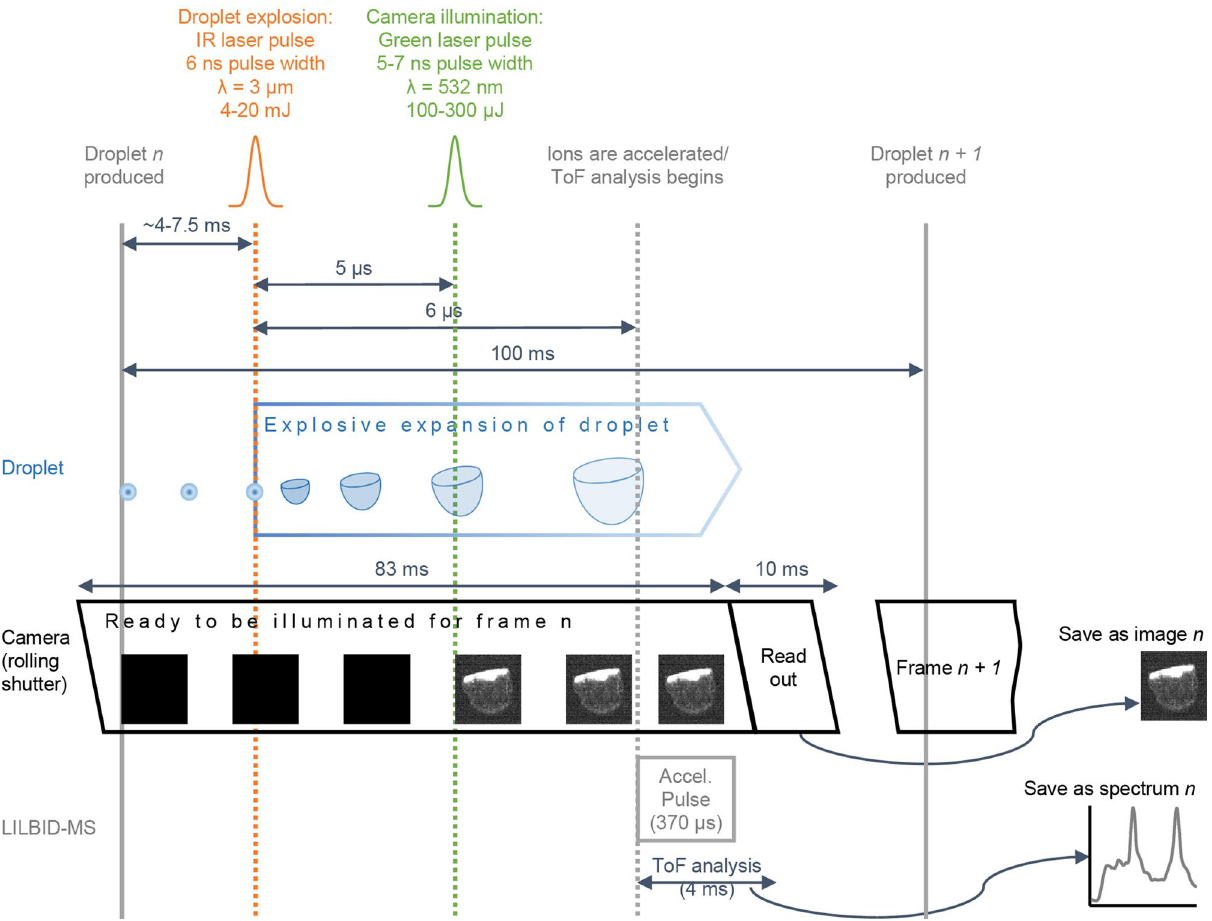
Figure 5. Timing and settings of lasers, droplet emitter, camera, LILBID-MS, and data readout for LILBID laser dissociation curves. The infrared laser pulse illuminates the droplet, resulting in its explosive expansion. Five µs after the beginning of the droplet explosion, the droplet is illuminated with a pulsed green laser, which allows the capture of the droplet explosion on the camera. One camera frame is produced per droplet. For each frame, the camera’s exposure time is 83 ms, and light arriving at the camera detector would be added over the entire exposure time. However, since the region of interest is only illuminated during the green laser pulse (5–7 ns pulse width), a snapshot of the droplet is recorded. One µs after droplet illumination, ions are accelerated into the ToF, and ToF analysis begins. The camera readout and ToF readout for each droplet n are saved as image n and spectrum n , respectively. The exposure time for frame n + 1 begins before the emission of the droplet n + 1. Laser energy was measured outside the ion source. This diagram was prepared in Powerpoint 2013 (https